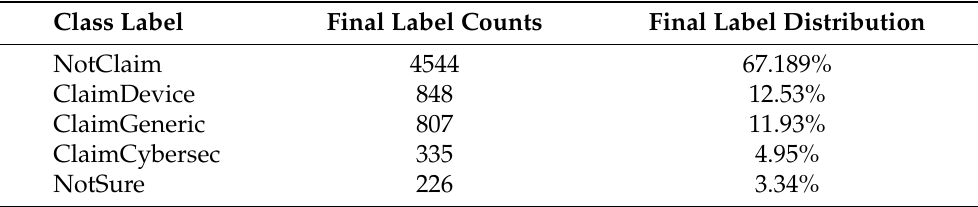
Table 3. Number of sequence labels and label distribution in each class.